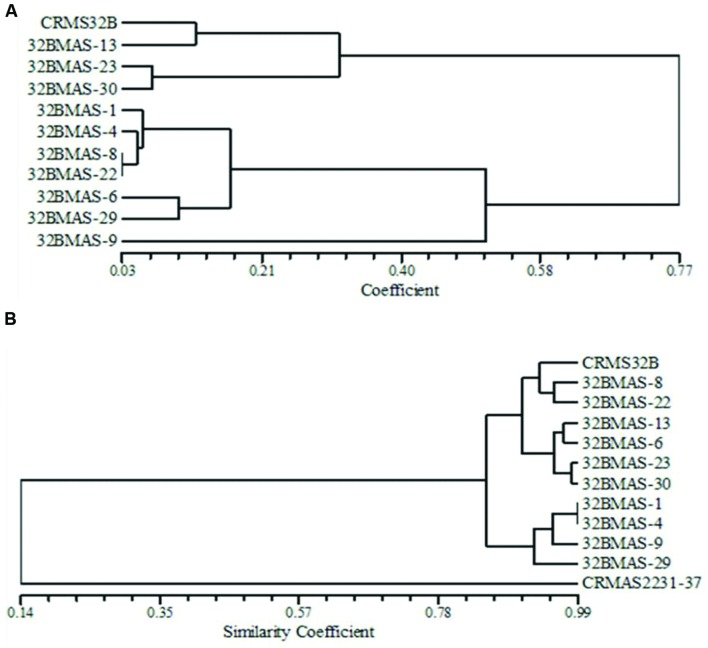
Dendrograms illustrating the genetic relationship between parents and pyramid lines. (A) Based on morphological and quality characteristics. (B) Based on microsatellite markers.